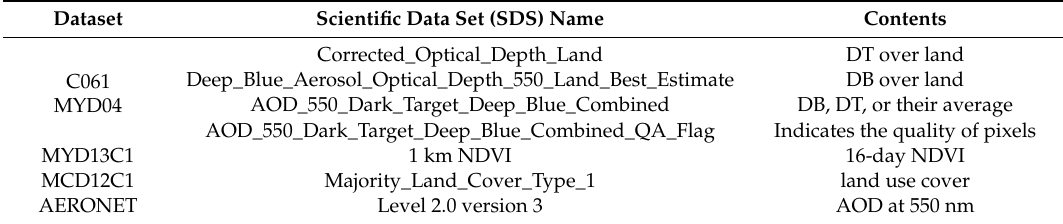
Figure 1. Study region and aerosol robot network (AERONET) sites (red circle). Table 1. Summary of the dataset used in the current study at a global scale from 2003 to